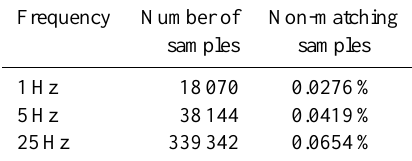
Fig. 14: Sample timing delay